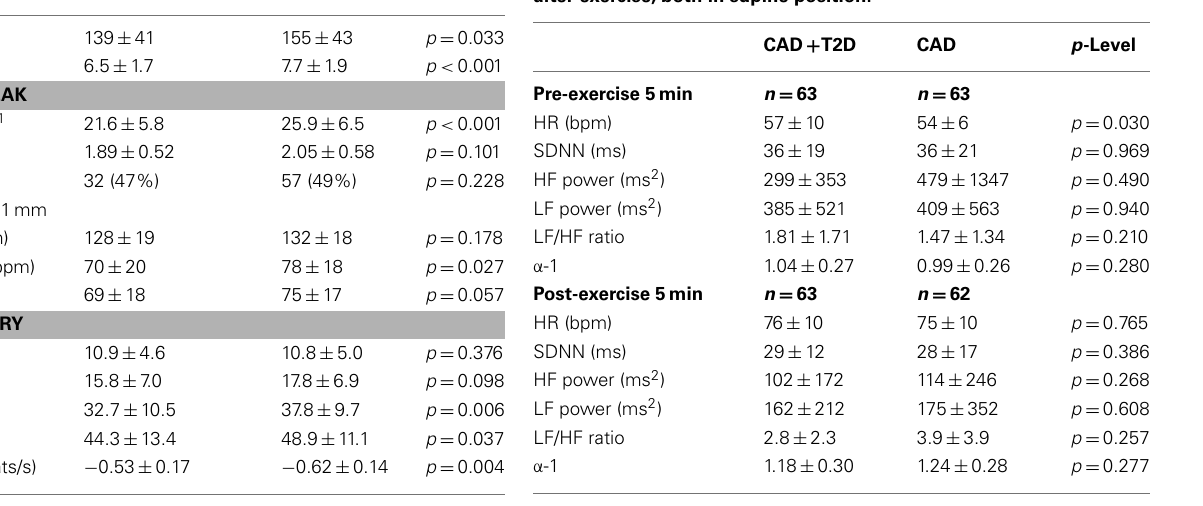
Table 2 | Maximal exercise capacity and heart rate recovery. Table 3 |Average values of linear and non-linear heart rate variability before exercise (5min) and in post-exercise condition from 3 to 8min after exercise, both in supine